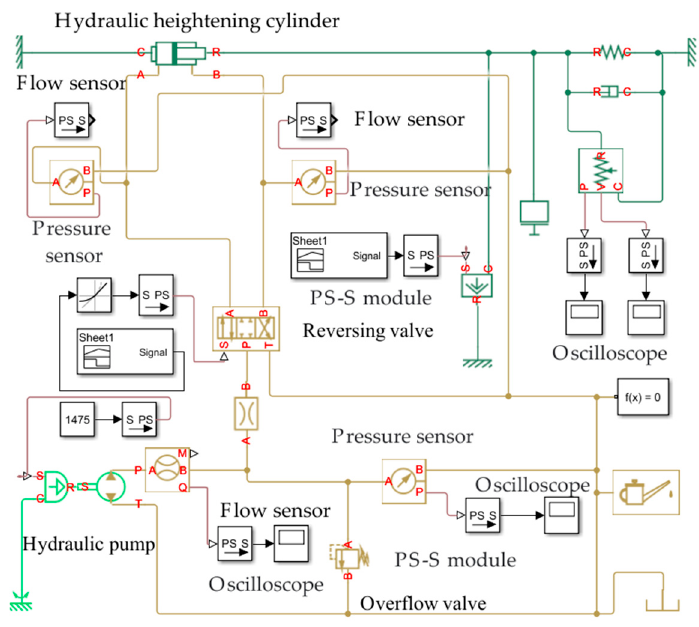
Figure 5. The simulation model of the hydraulic heightening